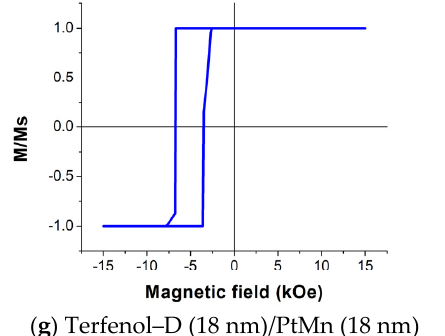
Figure 8. The hysteresis loops of 18 nm thick Terfenol–D coupling with PtMn at the PtMn thickness of ( a ) 0 nm, ( b ) 3 nm, ( c ) 6 nm, ( d ) 9 nm, ( e ) 12 nm, ( f ) 15 nm, and ( g ) 18 nm.